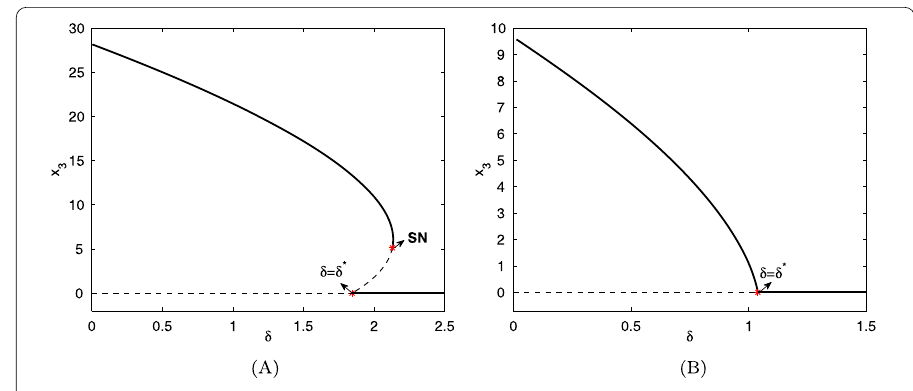
Figure 2 One parameter bifurcation diagram of δ . ‘SN’ is the saddle-node bifurcation. The dash curve represents unstable equilibrium while the solid curve represent stable equilibrium. Here we set b = 50 for ( A ) and b = 10 for ( B ). The other parameter values are: η = 0.01, a = 0.22, β 1 = 0.2, β 2 = 0.1, k = 0.4, γ = 0.45, m A = 0.45, m J =